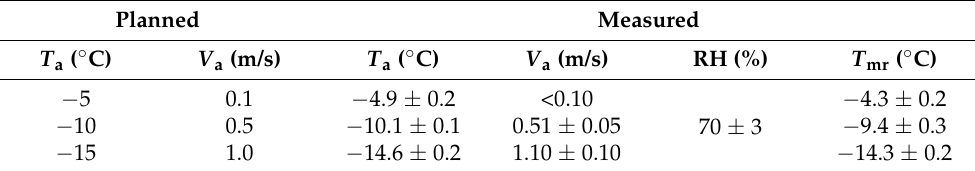
Table 5. Measured environmental parameters during the experiment (Mean ± SD).